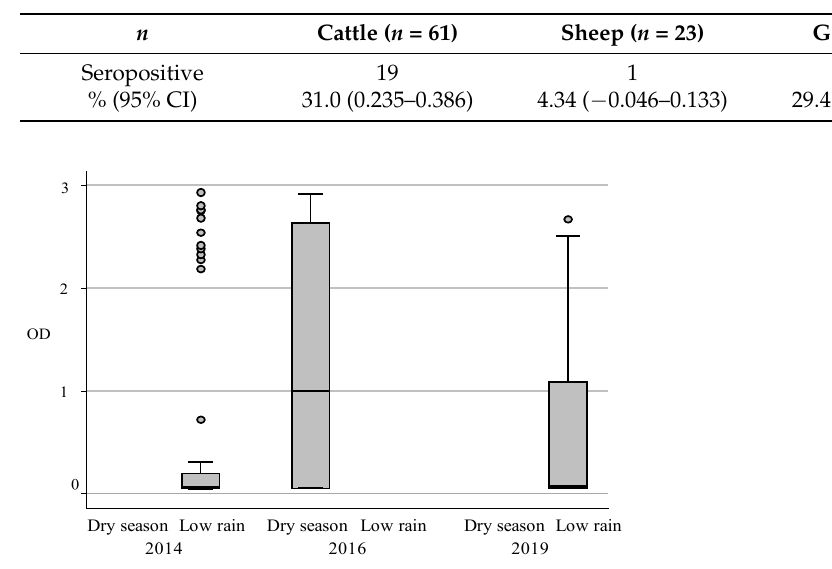
Table 3. Number of seropositive and percentage (95% CI) of animals from 18 single or 13 mixed households sampled in Maasai Mara farms between 2014 and 2019 that were seropositive for CCHF.